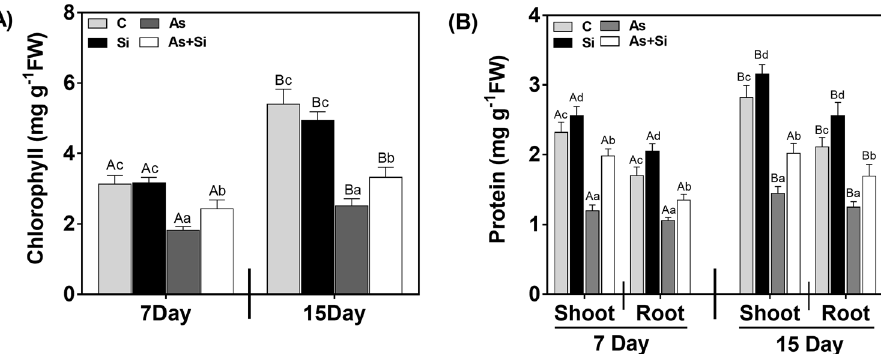
and As (III) treatment (Table 2). Arsenic content in only As (III) treated plants was more in roots (1.256 mg g − 1 DW) than shoots (0.825 mg g − 1 DW) at 15 d, while at 7 d no significant difference was observed between shoots decrease in shoot by 66% and 49%, and in root it was 35% and 44% at 7 and 15 d, respectively, as compared to As (III) alone (Table 2). Overall, As content was higher in shoots and roots at 15 d compared to 7 d.